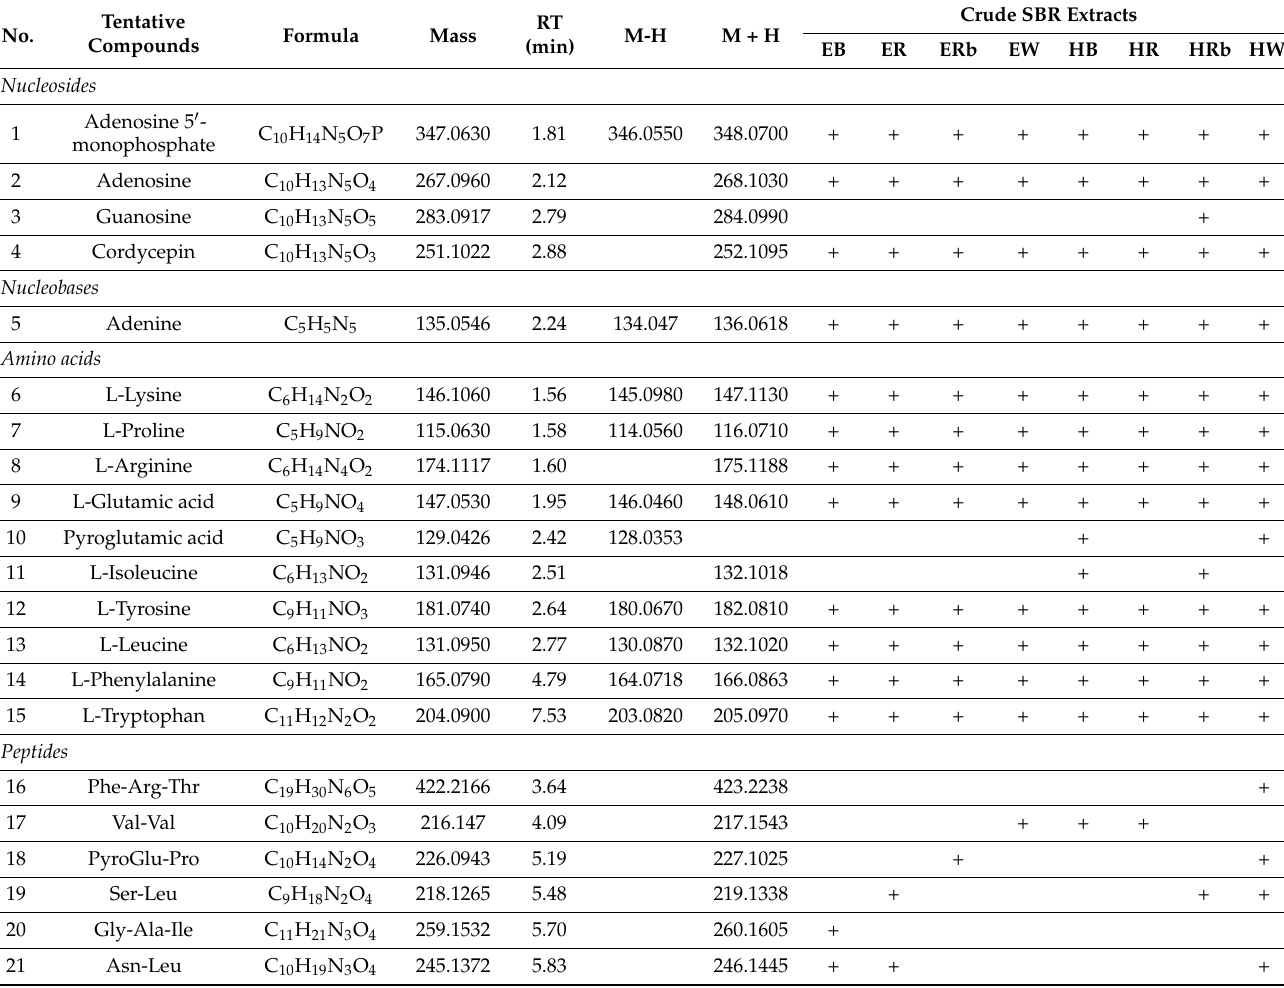
Table 7. Tentative identification of compounds detected in crude SBR extracts using LC-QTOF-MS/MS analysis. Tentative No. Compounds